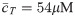
Structure of the nullclines at two different values of a) c¯T=54μM, b) c¯T=75μM.A black line corresponds to the nullcline c˙d=0, while the orange line indicates c˙sr=0. The functions f1 and g2 are the elements of the diagonal of the Jacobian matrix defined as f1=∂cdc˙d and g2=∂csrc˙sr.